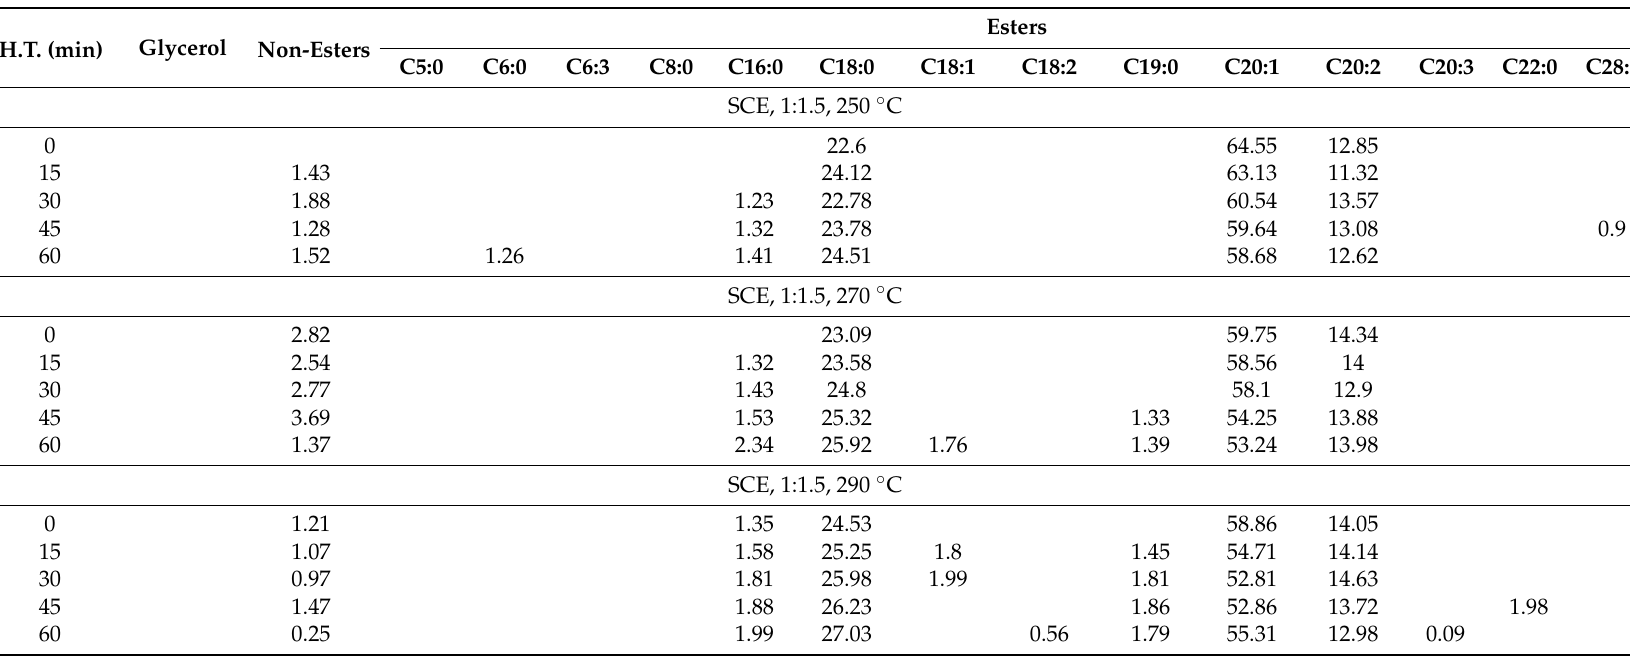
Table 5. The weight percentage of compounds according to the carbon number of liquid products obtained at different transesterification temperature for different holding times for waste pig fat to ethanol ratio of